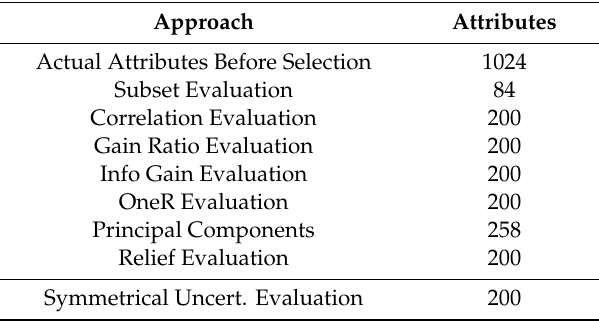
Table 1. Total number of attributes selected by the different algorithms. The 200 most important features ranked according to importance are retrieved.